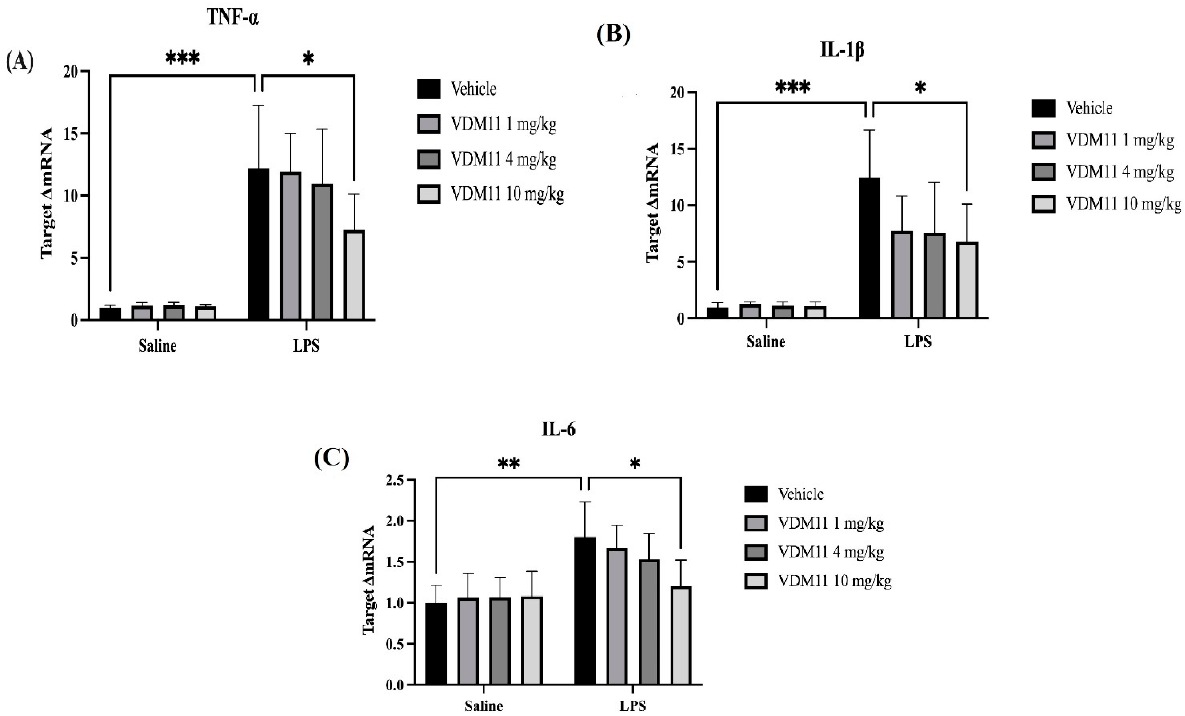
Figure 11. Anandamide reuptake inhibitor VDM11, 10 mg/kg, substantially lower LPS-induced elevation of TNF- α ( A ), IL1 ( B ), and IL6 ( C ) in the hippocampus. * p < 0.05; ** p < 0.01; *** p < 0.001.